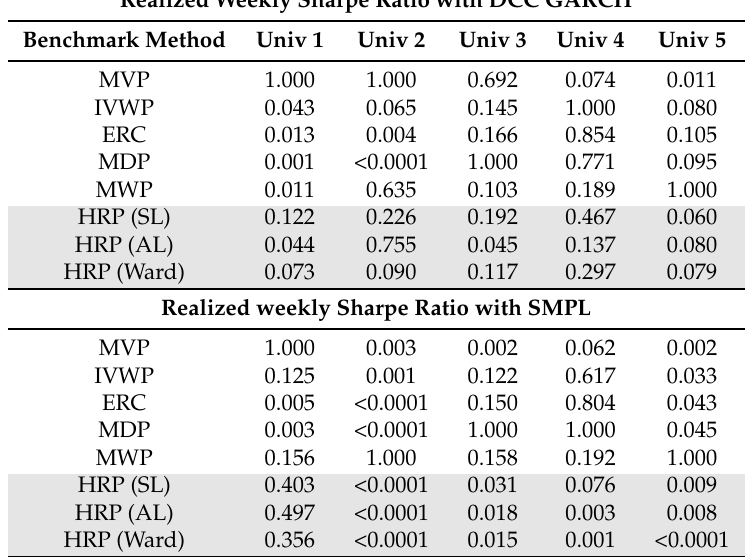
Table 8. p c -value for different choices of benchmark models when the loss function considered is negative of weekly Sharpe ratio and the portfolio is rebalanced